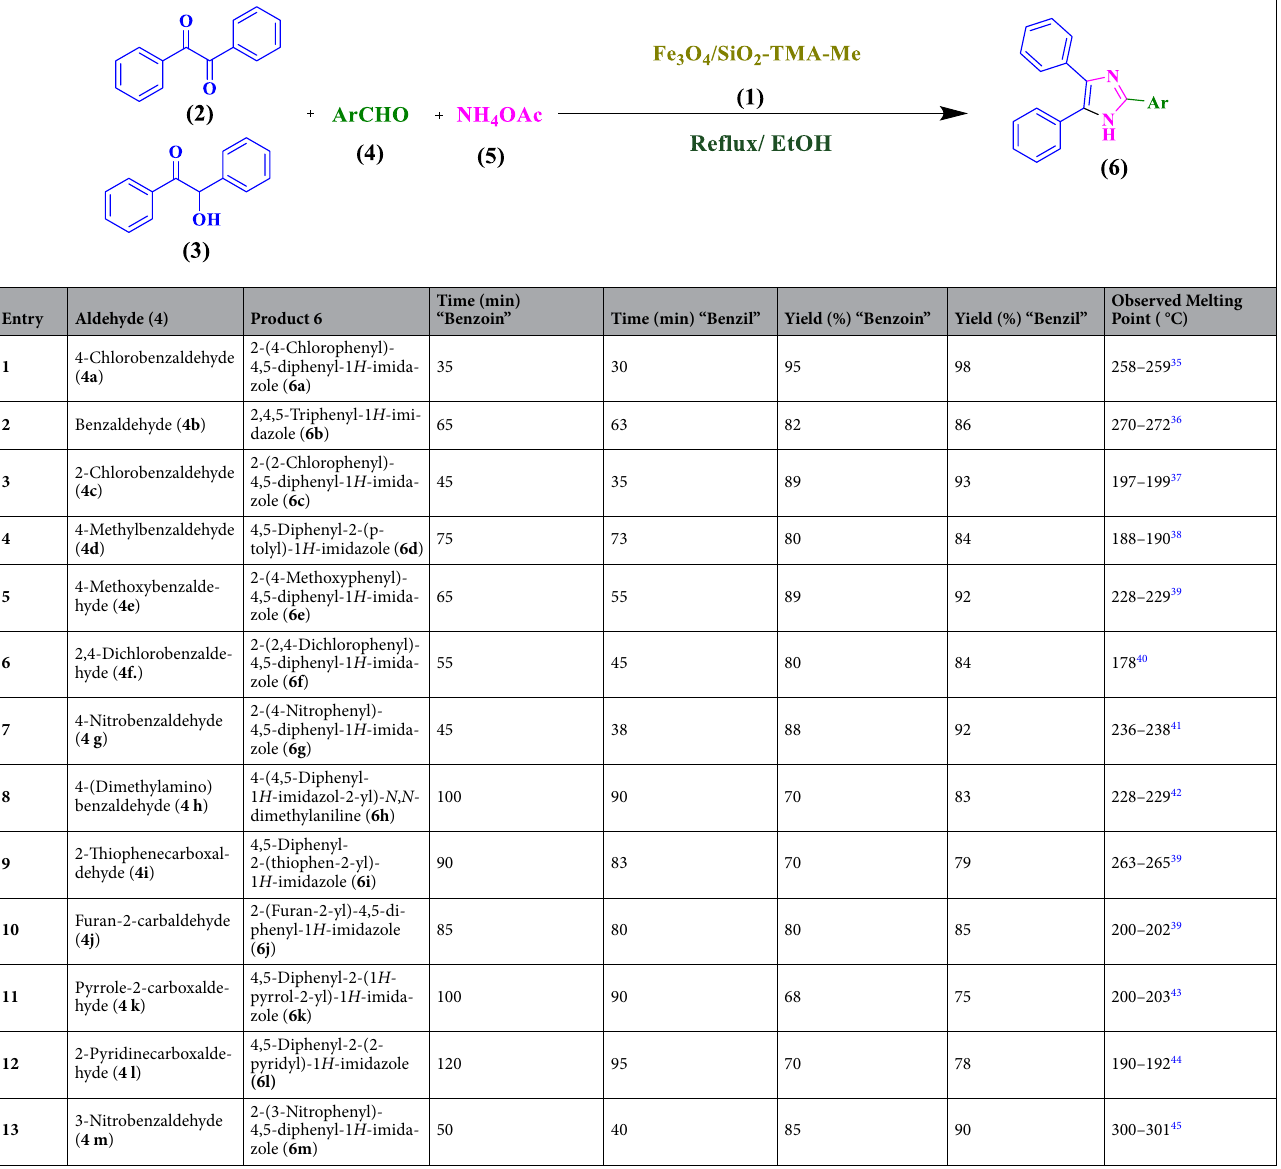
Afterward, the obtained solid was collected with an external magnet, washed several times using distilled water and EtOH (96%) and then dried at 45 °C for 3 h.